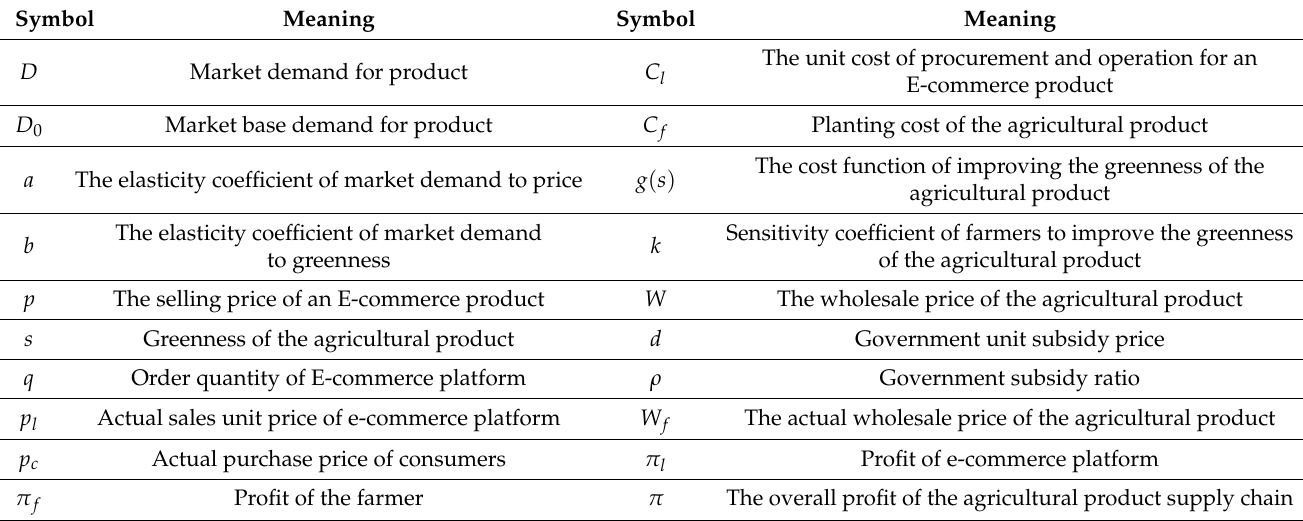
Table 1. Research model symbols and